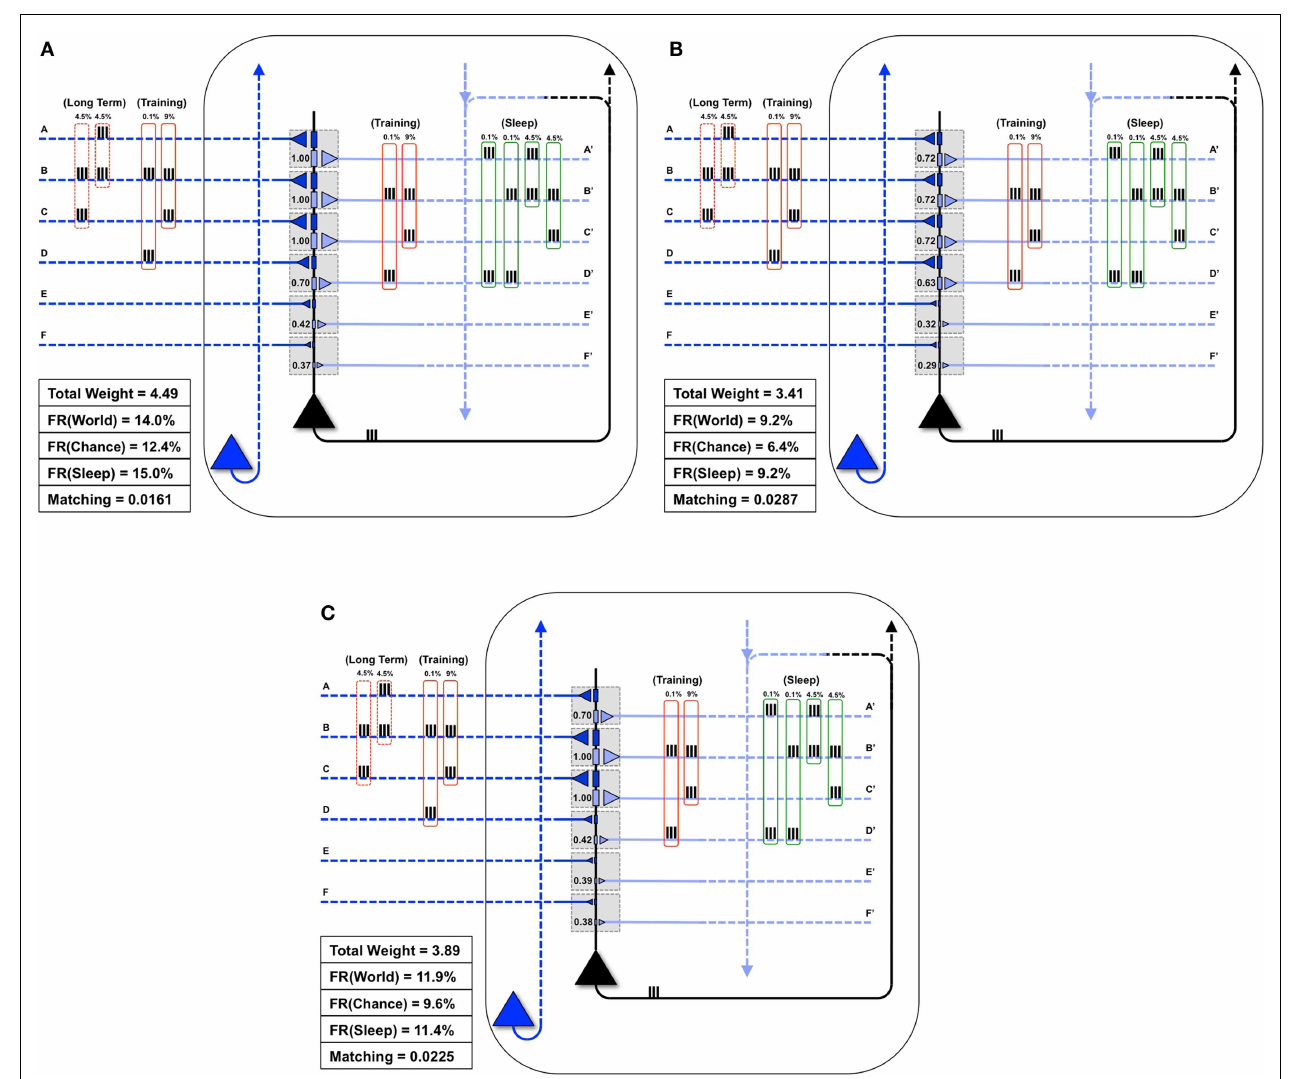
this sleep period, the synapses D/D (cid:48) corresponding to the spurious activations (A and D 0.1%, B and D 0.1%) become further potentiated. Afterward, all synapses are linearly depressed so the total synaptic weight after sleep is comparable to the neuron shown in Figure 5D . As a result, Matching is degraded. (C) The neuron from Figure 5B is allowed to undergo both synaptic potentiation as well as activity-dependent down-selection in wake. Since the Training of this particular day does not include correlations on inputs A and B (but they are still present in the Long-Term statistics of the World ), synapses A/A (cid:48) become depressed. Thus, Matching is